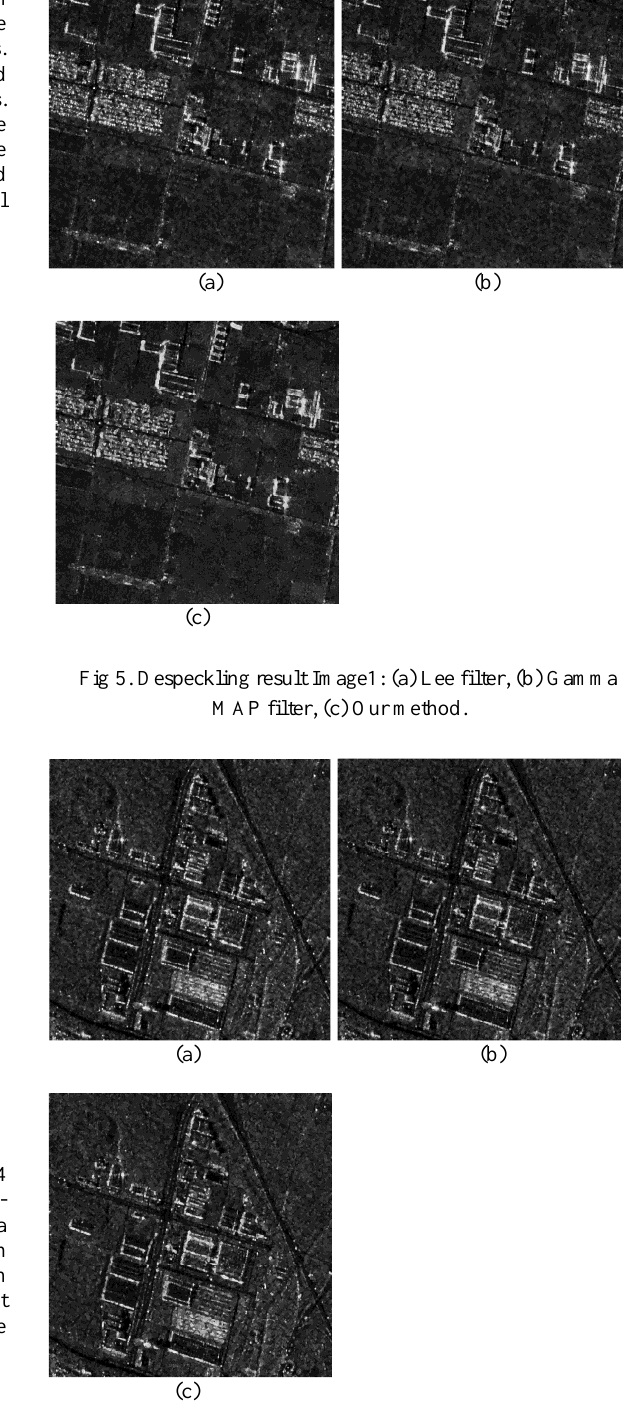
Fig 6. Despeckling result Image2: (a) Lee filter, (b) Gamma MAP filter, (c) Our